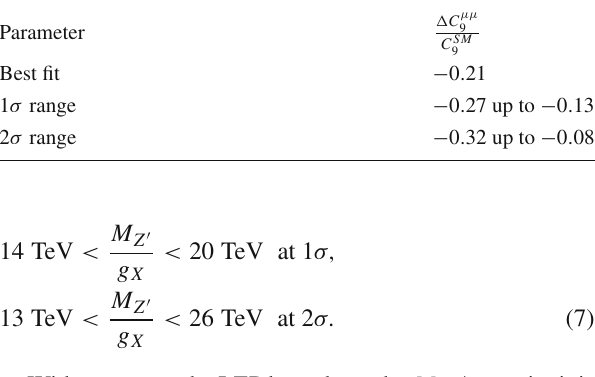
Table 4 Constraints on the C data. Taken from Ref.